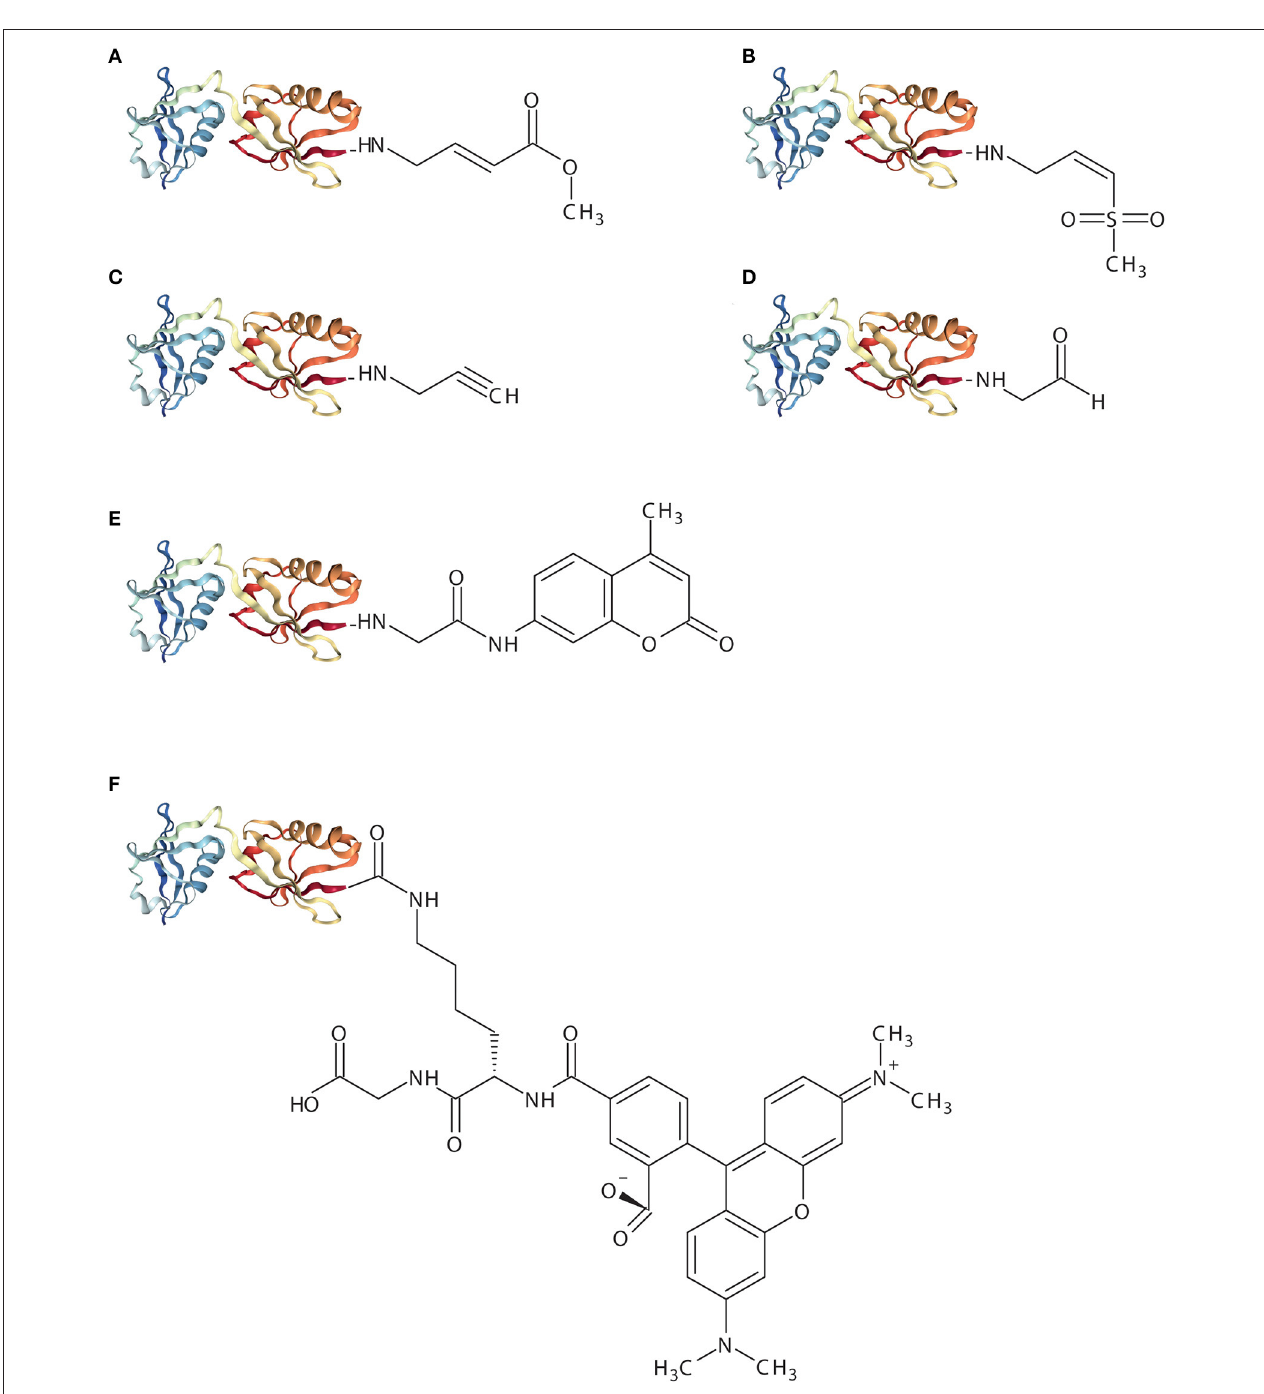
FIGURE 2 | Schematic representation of ISG15-based assay reagents. The X-ray crystal structure represents mouse ISG15 (PDB: 5TLA) and implies ISG15 1 − 155 . (A) , ISG15-VME (B) , ISG15-VS (C) , ISG15-PRG (D) , ISG15-CHO (E) , ISG15-AMC (F) , ISG15-TAMRA-(5-thioLys)-Gly.